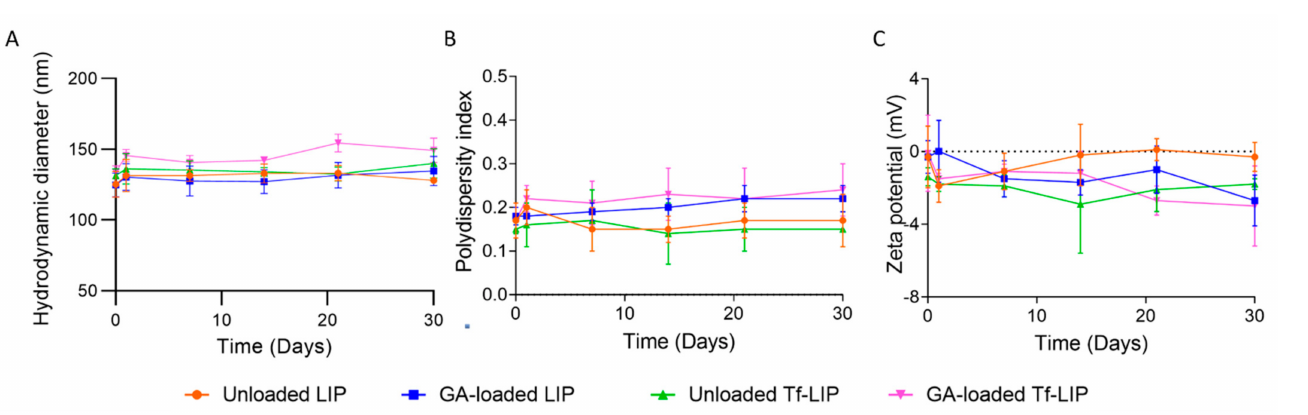
Figure 4. Physicochemical properties of unloaded (orange), GA-loaded (blue), Tf-functionalized (green), and GA-loaded Tf-functionalized liposomes (pink) in terms of ( A ) hydrodynamic diameter, ( B ) PdI, and ( C ) zeta potential, stored at 4 ◦ C for 1